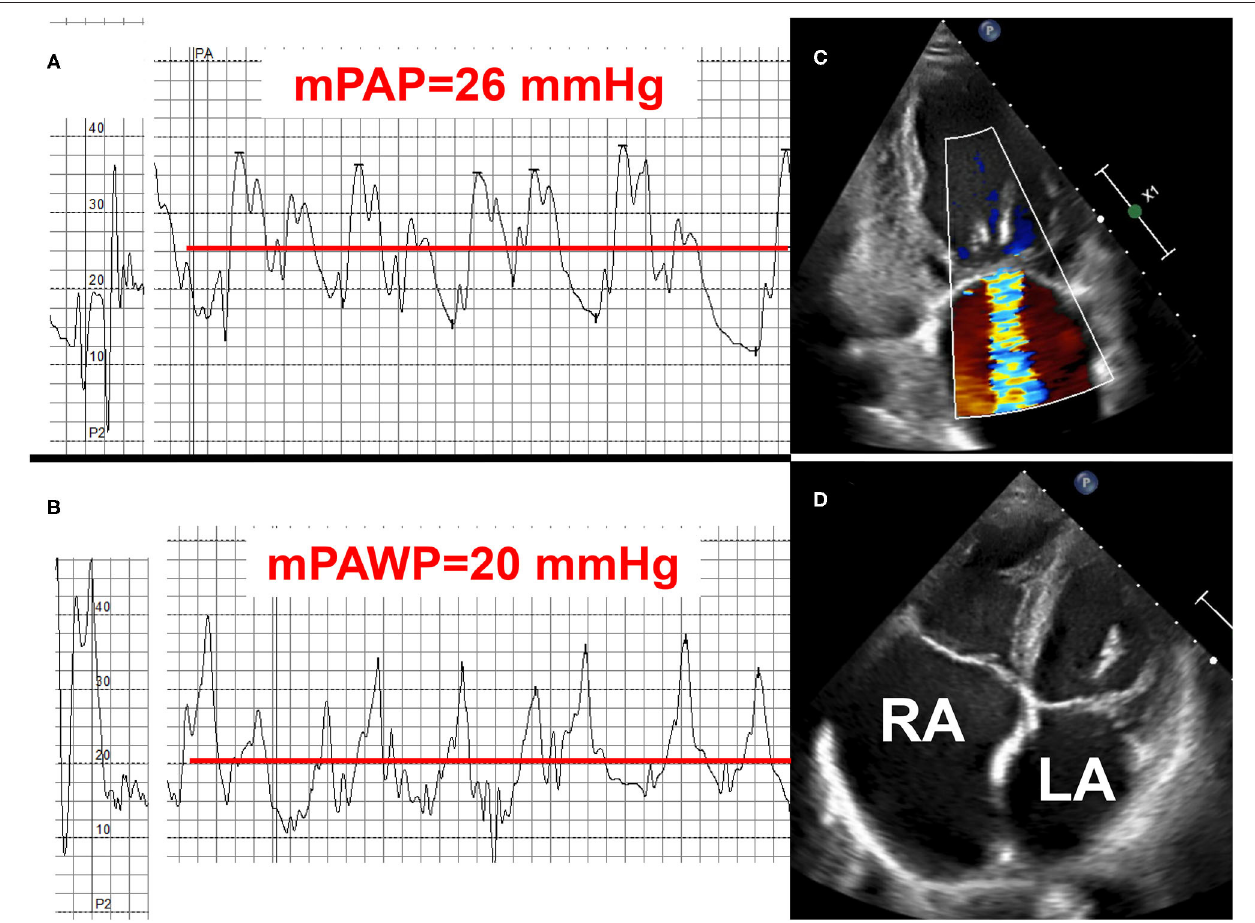
FIGURE 4 | Example 1 of a patient with a mid-range left ventricular ejection fraction (LVEF) and pulmonary hypertension (PH): 78-year old female with permanent atrial fibrillation and coronary artery disease with previous myocardial infarction and percutaneous intervention of the occluded left circumflex artery (LCX). NYHA class II. LVEF 48%, moderate mitral regurgitation (MR), biatrial dilatation (LA: left atrium, RA: right atrium). Mean pulmonary artery pressure (mPAP): 26 mmHg (A) , mean pulmonary artery wedge pressure (mPAWP) 20 mmHg (B) , pulmonary vascular resistance: 1.7 Wood units. Left atrial pressure elevation and isolated post-capillary PH, respectively, are most likely multifactorial [left ventricular dysfunction, functional MR due to distorted left ventricular geometry after LCX infarct and atrial/annulus dilatation (C) , left atrial dysfunction in the context of atrial fibrillation (D) ]. Management with loop diuretics, spironolactone, candesartan or sacubitril/valsartan, and betablocker. Rhythm control of atrial fibrillation may be considered but may not be successful; no evidence-based indication for mitral valve repair.